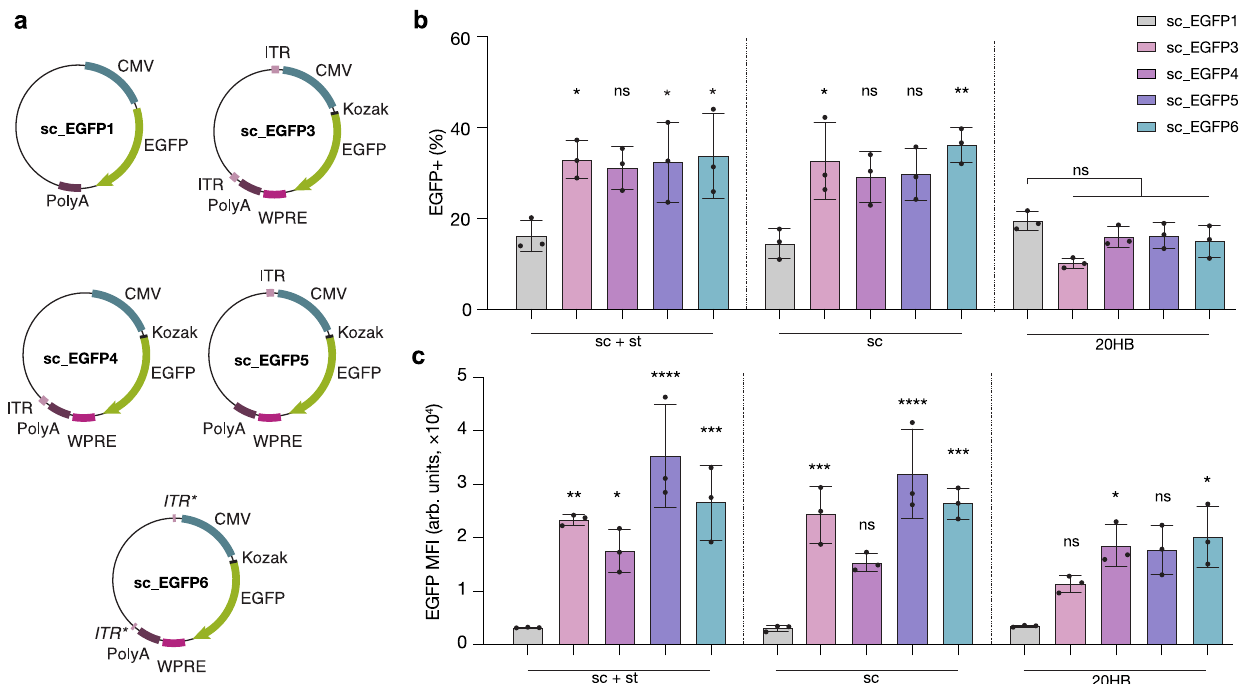
Fig. 3 | Enhanced gene expression from alternative scaffold sequences. a Scaffold designs where sc_EGFP1 represents the initial scaffold design, and sc_EGFP3/4/5/6 include additional sequence features such as ITRs (light pink), or ITR binding domains ( ITR* ), Kozak sequence (black), and WPRE (dark pink). b , c Comparison of transfection ef fi ciency in HEK293T cells as determined by EGFP+cells( b )andmean fl uorescentintensityofEGFP+cells( c ).Forconditionsc+ st, scaffold sc_EGFP3 ( p =0.0267), sc_EGFP5 ( p =0.0361) and sc_EGFP6 ( p =0.0168) demonstrated a higher percentage of EGFP+ cells, while scaffolds sc_EGFP3 ( p =0.0011), sc_EGFP4 ( p =0.0499), sc_EGFP5 ( p =3.10×10 − 7 ) and sc_EGFP6 ( p =0.0001) demonstrated higher MFI compared to sc_EGFP1. For condition sc, scaffold sc_EGFP3 ( p =0.0118) and sc_EGFP6 ( p =0.0014) demonstrated